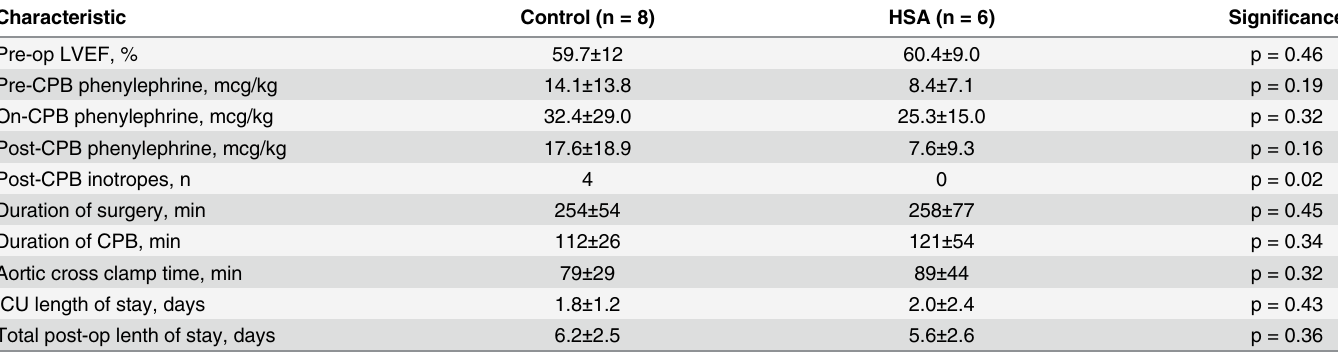
Table 2. Intraoperative and postoperative patient characteristics (mean ±